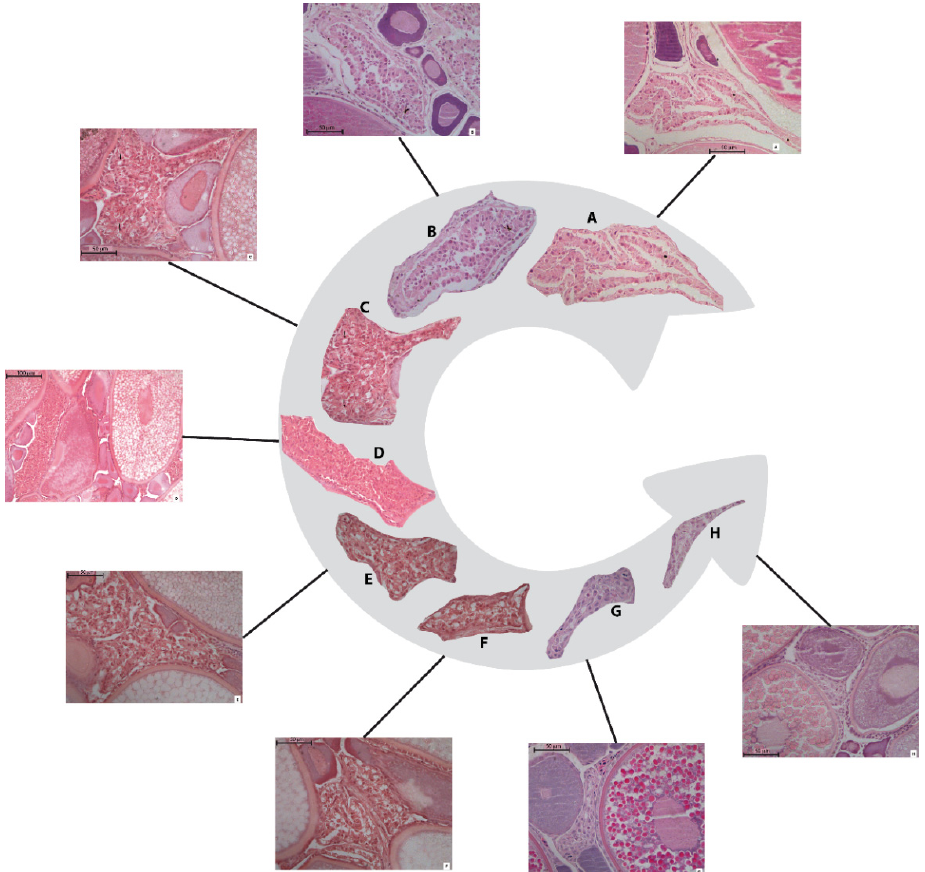
Figure 3. Evolution of postovulatory follicle (POF) resorption process (in the grey arrow). The rectangular panel showed each POF stage within the histological section of ovary. ( A ) POF I with no sign of degeneration; ( B ) POF I (BIS) with early evidence of degeneration; ( C ) POF II characterized by the appearance of vacuoles; ( D ) POF III showing size reduction and lumen shrinkage; ( E ) POF IV with compacted, flat aspect, folder and lumen almost not still visible (two POFs are distinguishable in the picture); ( F ) POF V shrunk appearance, lumen not visible, almost triangular-shaped (two POFs are distinguishable in the picture); ( G ) POF VI very small size, elongated shape; ( H ) POF VI (BIS) very late degeneration phase, with a triangular shape, representing the last appearance of recognisable POF. See Figure S1 for more